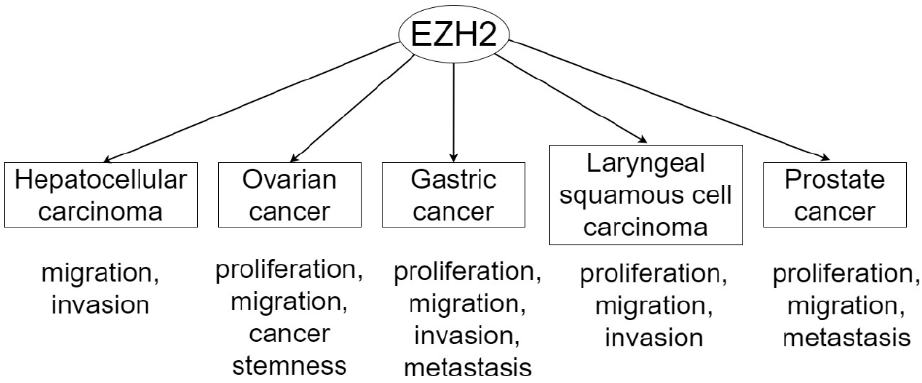
Figure 5. The role of EZH2 in the biological processes of carcinogenesis in five epithelial